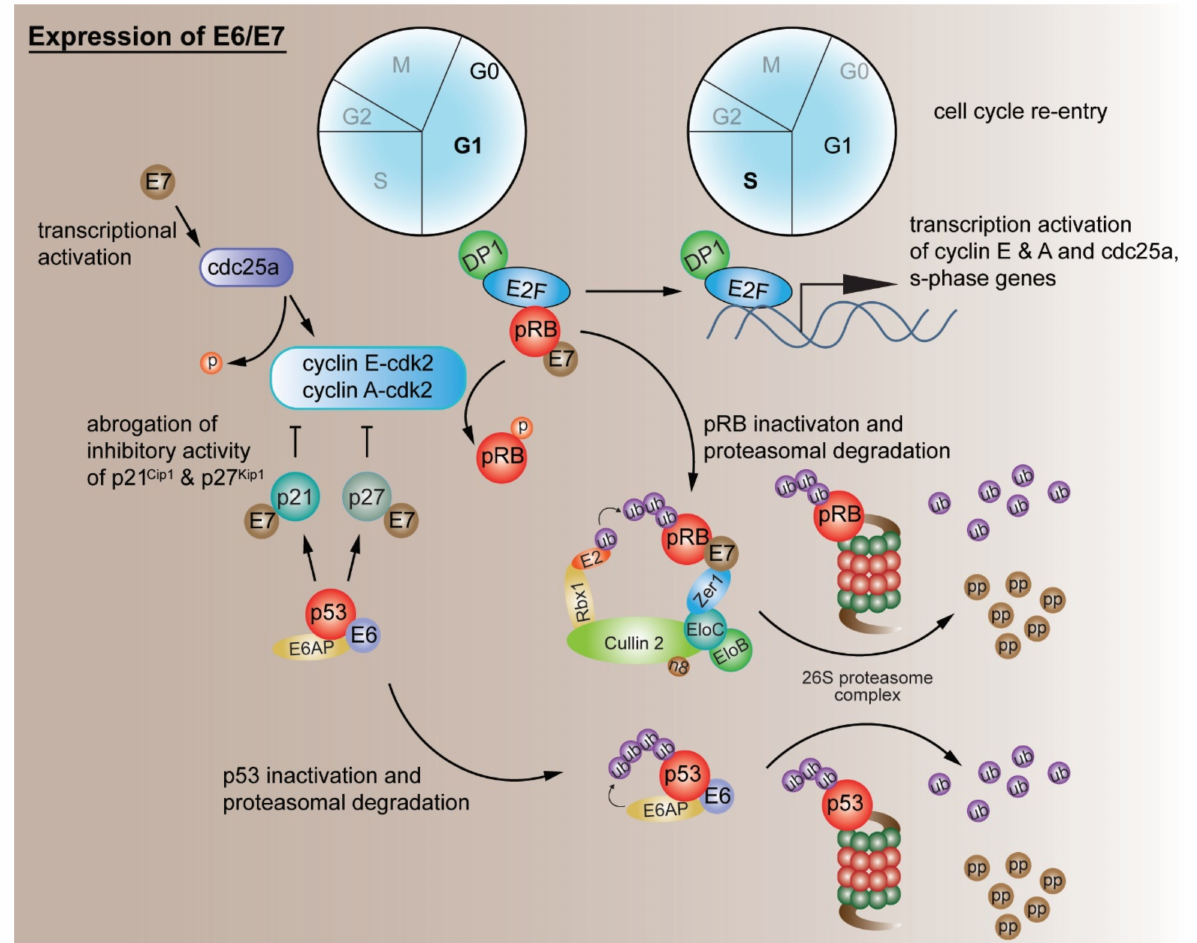
Figure 4. Evading growth suppressors. Unlike normal cells, where the growth and proliferation are tightly controlled, cells expressing HPV oncoproteins act to evade the key tumour suppressors pRB and p53. HPV-E7 can associate with pRB and inactivate the repressive function of the pRB/E2F transcription complex, leading to the expression of S-phase genes (cell cycle regulators, including cdc25a, cyclin E and A and replication enzymes and others) in otherwise cell cycle-exited and differentiating keratinocytes, leading to re-entry to the S phase. Further, high-risk E7 can downregulate pRB via proteasomal degradation via the cullin-2 ubiquitin ligase complex. HPV-16 E7 associates with cdk inhibitors p21 Cip1 and p27 Kip1 , abrogates the inhibition of cdk2 activity and enhances the transcriptional activation of cdc25a, leading to the dephosphorylation of inhibitory phosphorylation in cdk-2/cyclin E/A. This leads to activation of the p53 tumour suppressor; however, high-risk E6 can inactivate and degrade p53 via the ubiquitin proteasome pathway involving the E6AP ubiquitin ligase complex. ub—ubiquitin and pp—2-25 residue